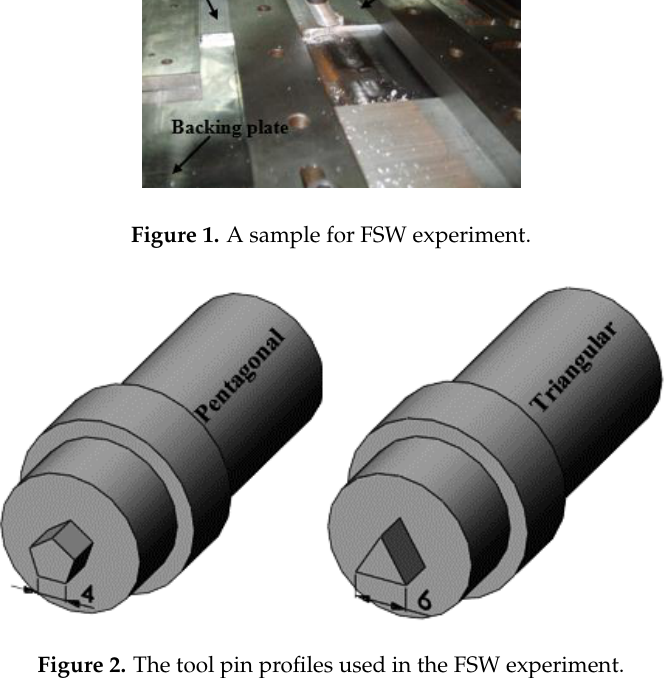
Figure 2. The tool pin profiles used in the FSW experiment.